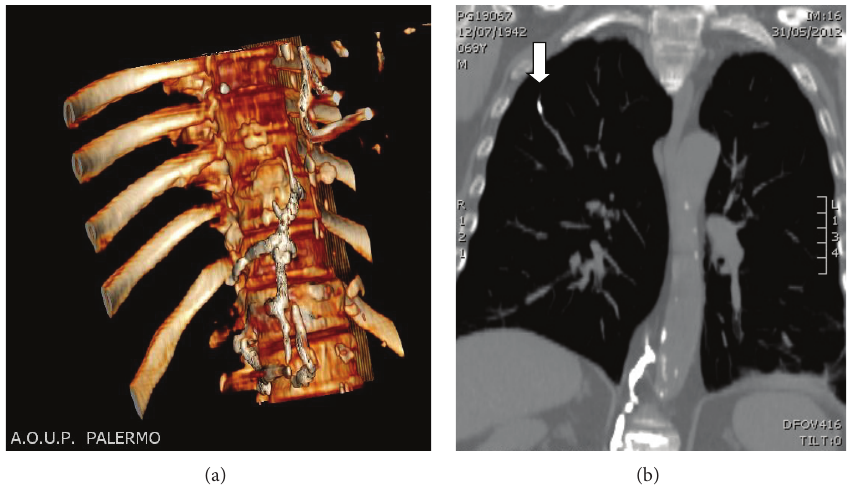
Figure 2: (a) Cement leakage into the Batson’s paravertebral venous system. (b) Pulmonary embolism (arrow: presence of cement in the subsegmentary and segmentary pulmonary arteries of the right superior